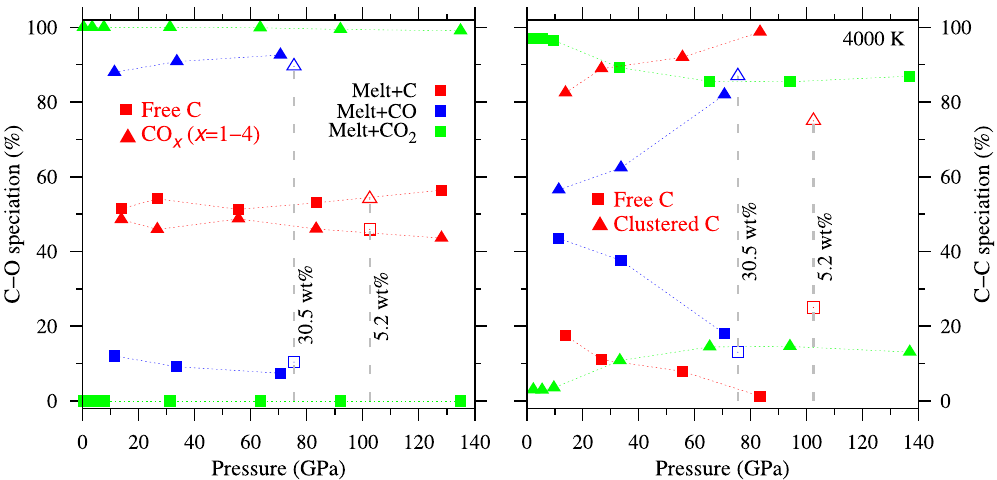
Figure 3. Speciation of CO and C components in MgSiO 3 liquid. Abundances of C-O and C-C speciation as a function of pressure at 4000 K for three cases of carbon incorporation in the melt: a) oxidized form of CO 2 , b) intermediate form of CO, and c) reduced form of elemental carbon. The amount of carbon in each case is equivalent to that of 16.1 wt.% CO 2 . The C-O speciation is divided into two groups: free C atoms (not coordinated/bonded with any oxygen), and the other C atoms which are bonded to one or more oxygen atoms. Similarly, the C-C speciation is divided into two groups: free C atoms (not coordinated/bonded with any other carbon), and the other C atoms which are bonded/coordinated with one or more carbon atoms. Also shown are the results for 5.2 and 30.5 wt.% equivalent cases at high pressures.